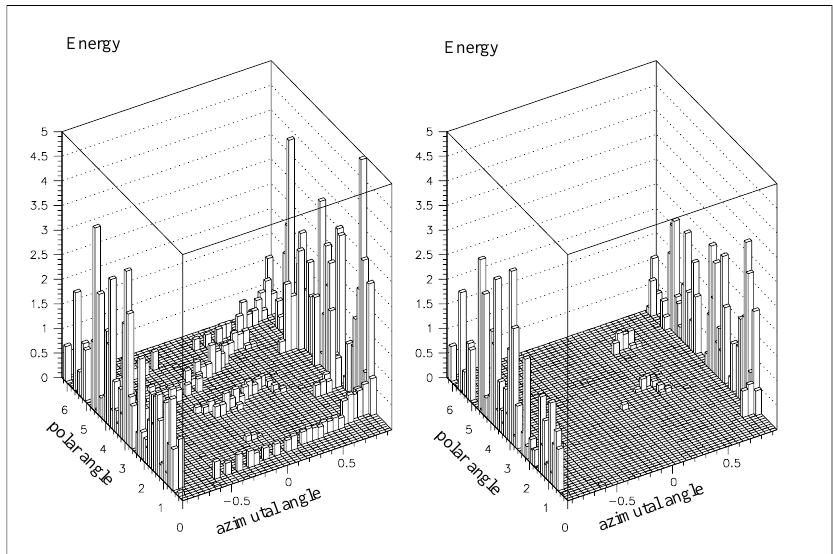
FIG. 70. The left-hand plot shows the energy deposition from Bethe-Heitler muons vs the cosine of the polar angle and azimuthal angle in the calorimeter for a 0.5 TeV COM collider. The right-hand plot shows the same distributions with a 1 ns timing